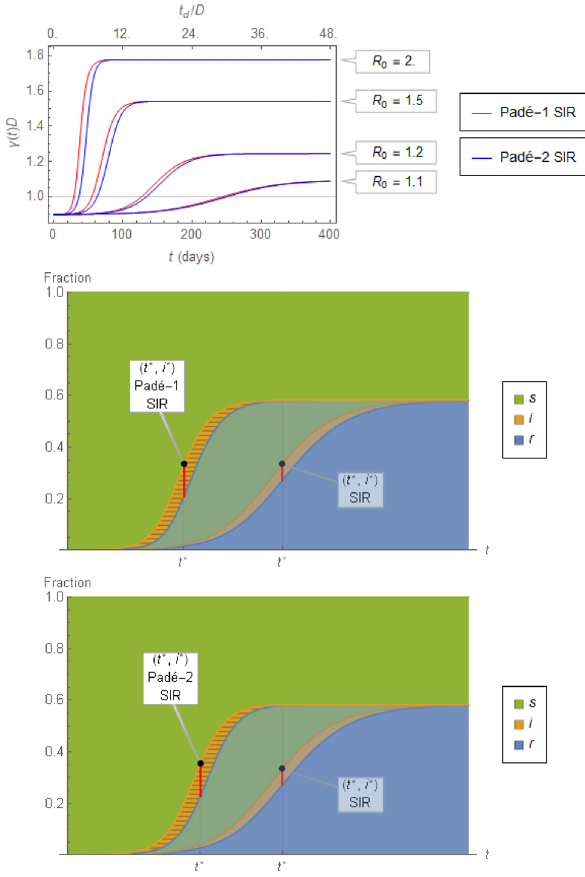
r ′ ( t )/ i ( t ) and the corresponding Figure 10. Top: Comparison between the inferred time-varying γ( t ) def = β D i n numerical integration of the first- 0.12 day − 1 for various R 0 def time-invariant 1 / D = = ( r ′ ( t )/ i ( t ) β s ( t ) β s ( t ) 2 / D ) and second-order ( r ′ ( t )/ i ( t ) i ′ ( t )/ i ( t ) ) Padé SIR equations. Middle and = − = − 1.5 according to the first- and s , i , r bottom: Stacked fractions of a population through an epidemic for R 0 { } = second-order Padé SIR model, superimposed on the standard SIR model (cf. Figure 1). The horizontal slices of equal length D shown in the orange area for i ( t ) are the continuous counterparts of the same area in the discretized plot of Fig.